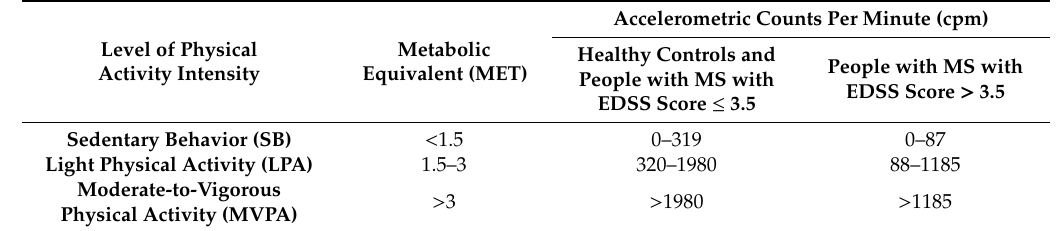
Table 2. List of accelerometric cut-points employed to classify the intensity levels of Physical Activity performed by people with Multiple Sclerosis and una ff ected individuals (adapted from [39]). Accelerometric Counts Per Minute (cpm) Level of Physical Metabolic Healthy Controls and People with MS with Activity Intensity Equivalent (MET) People with MS with EDSS Score > EDSS Score ≤ 3.5